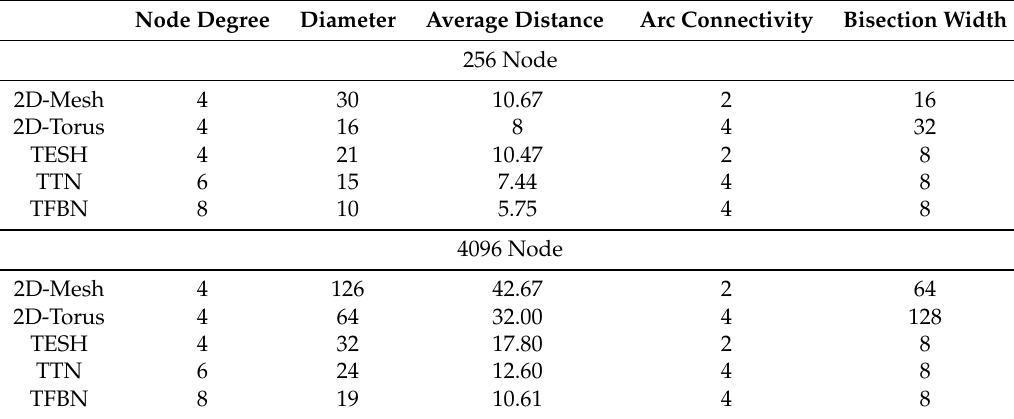
Table 1. Comparison of static network performance of various